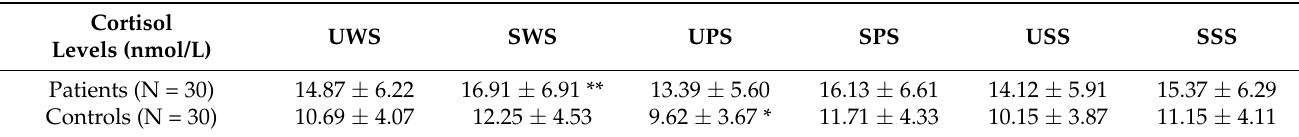
Table 2. The average levels of saliva cortisol for each group (depressed patient/control and stimu- lated/unstimulated).